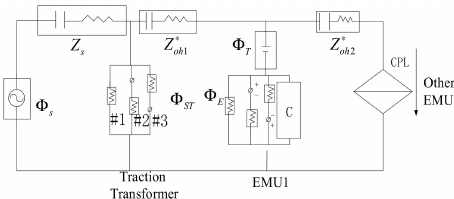
Figure 6. The flux–current circuit model of the traction network–EMU coupling